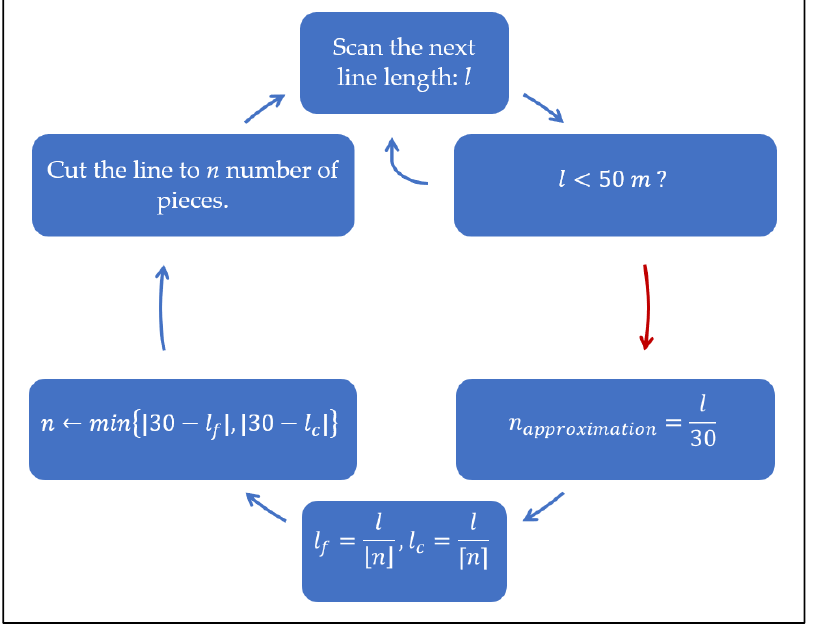
Figure 3. Length correction algorithm.